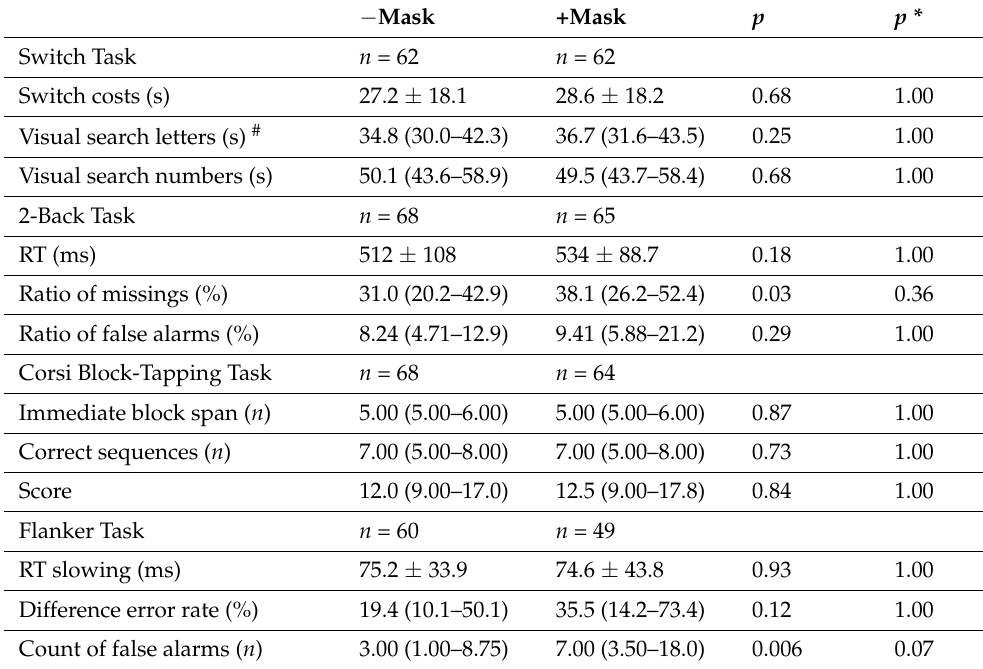
Table 2. Cognitive performance of children without ( − Mask) and with a mask